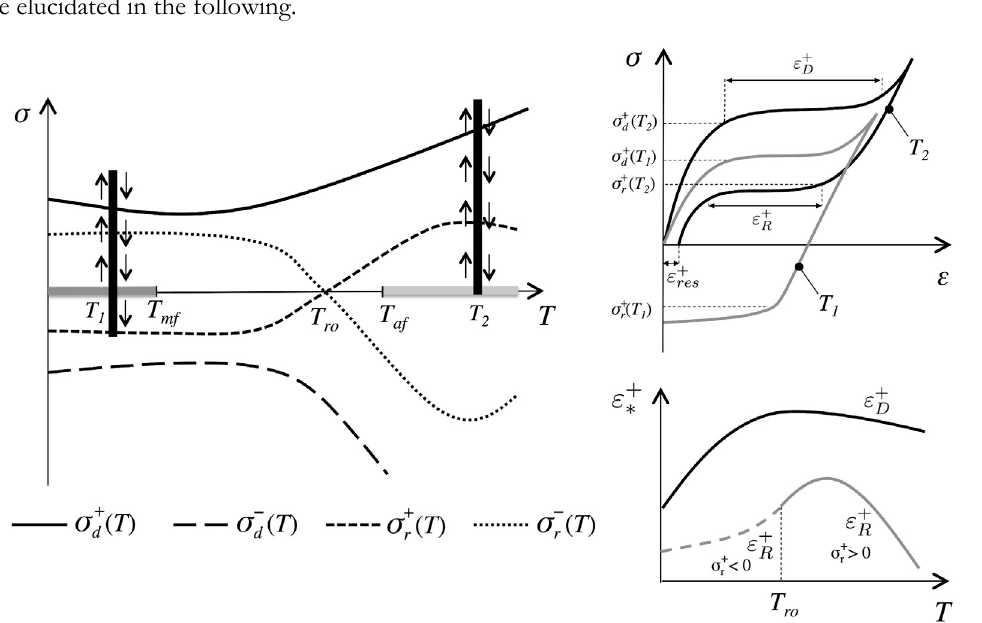
Figure 1: Left: typical phase diagram in  - T plane for SMAs. The figure shows the direct SIT lines to Ms+ ( as well as the reverse ones from Ms+ ( traction tests are shown at = T T . Bottom right: SMA typical relationships between direct ( 2 State-of-the-art and proposed